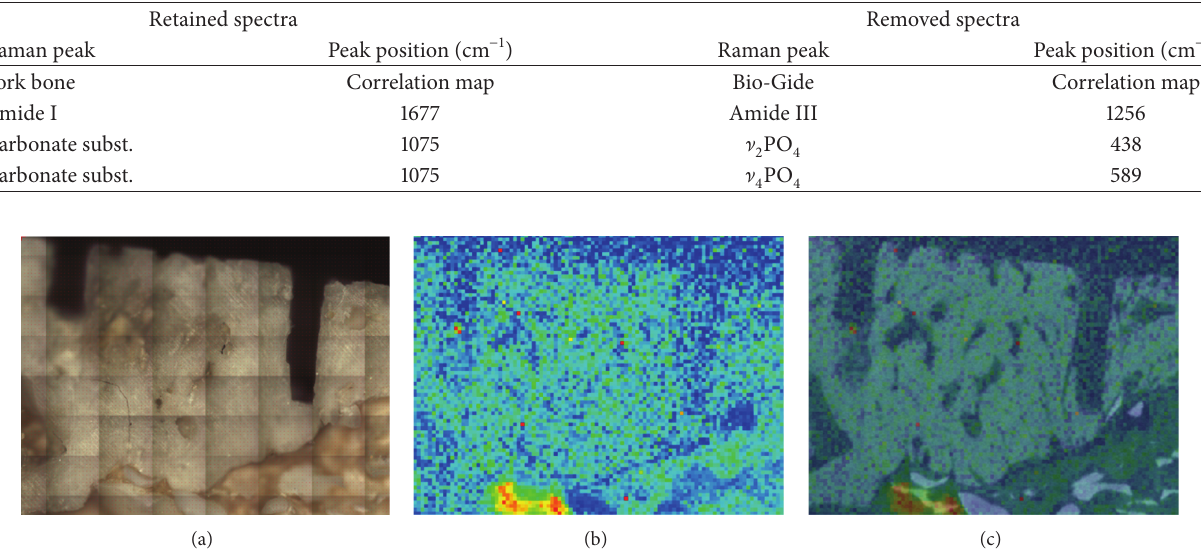
Table 3: Spectra showing a correlation greater than ± 0.9.